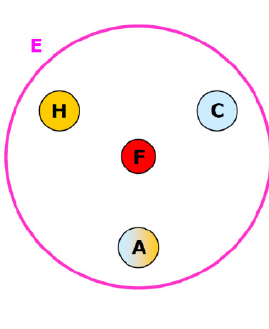
Fig. 3. – The 5 elements.